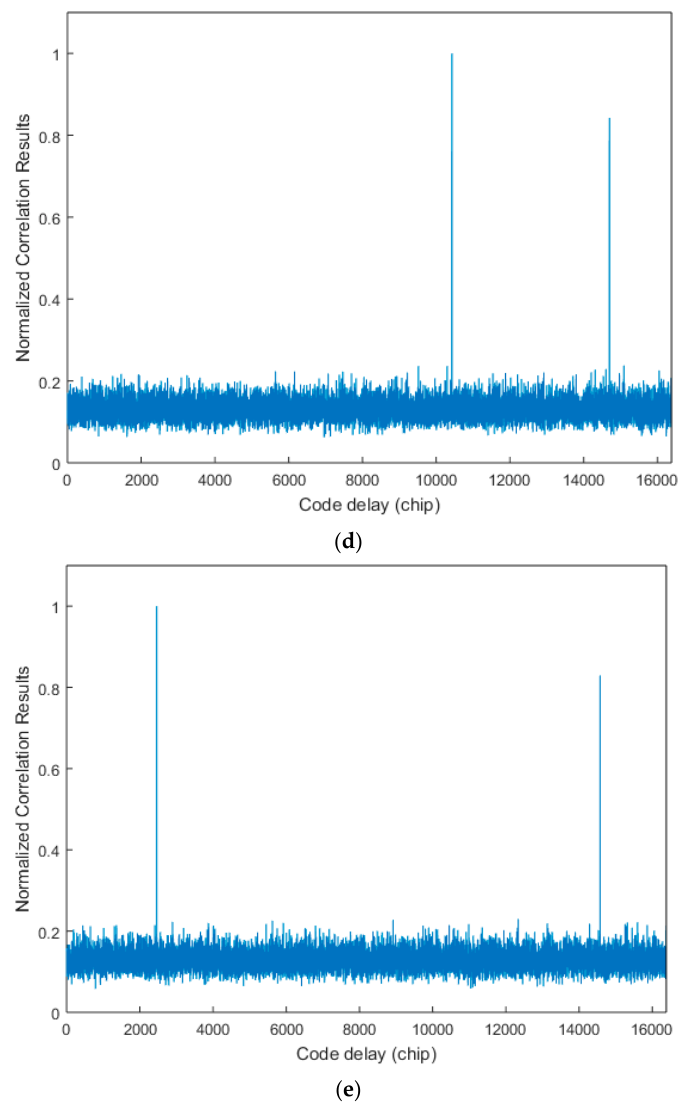
Figure 12. Normalized non-coherent integration of 31 non-coherent integration results of different incoming signal phase: ( a – c ) three significant autocorrelation peaks and ( d , e ) two significant autocorrelation peaks.